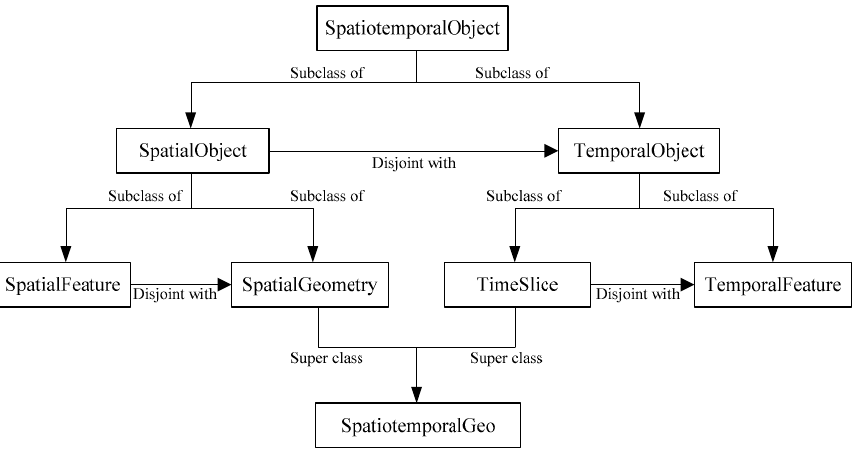
Figure 2 . The relations among the main stRDFS classes. Figure 2. The relations among the main stRDFS